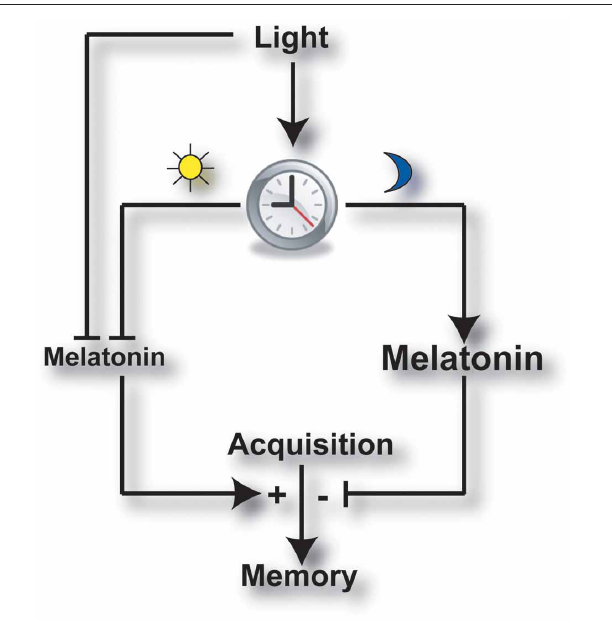
FIGURE 2 | Working model, illustrating the hypothesized rhythmic modulatory role of endogenous melatonin on memory processing. Cycling endogenous melatonin levels regulated by the circadian clock and by light/dark cycles, modulate the processing of newly acquired information into long-term memory. Inhibition ( (cid:2) ) of melatonin synthesis by the circadian clock or light directly, facilitates ( (cid:2) + ) long-term memory formation. Alternatively, the nighttime peak in melatonin levels imposes an inhibitory effect ( (cid:2) − ) on memory